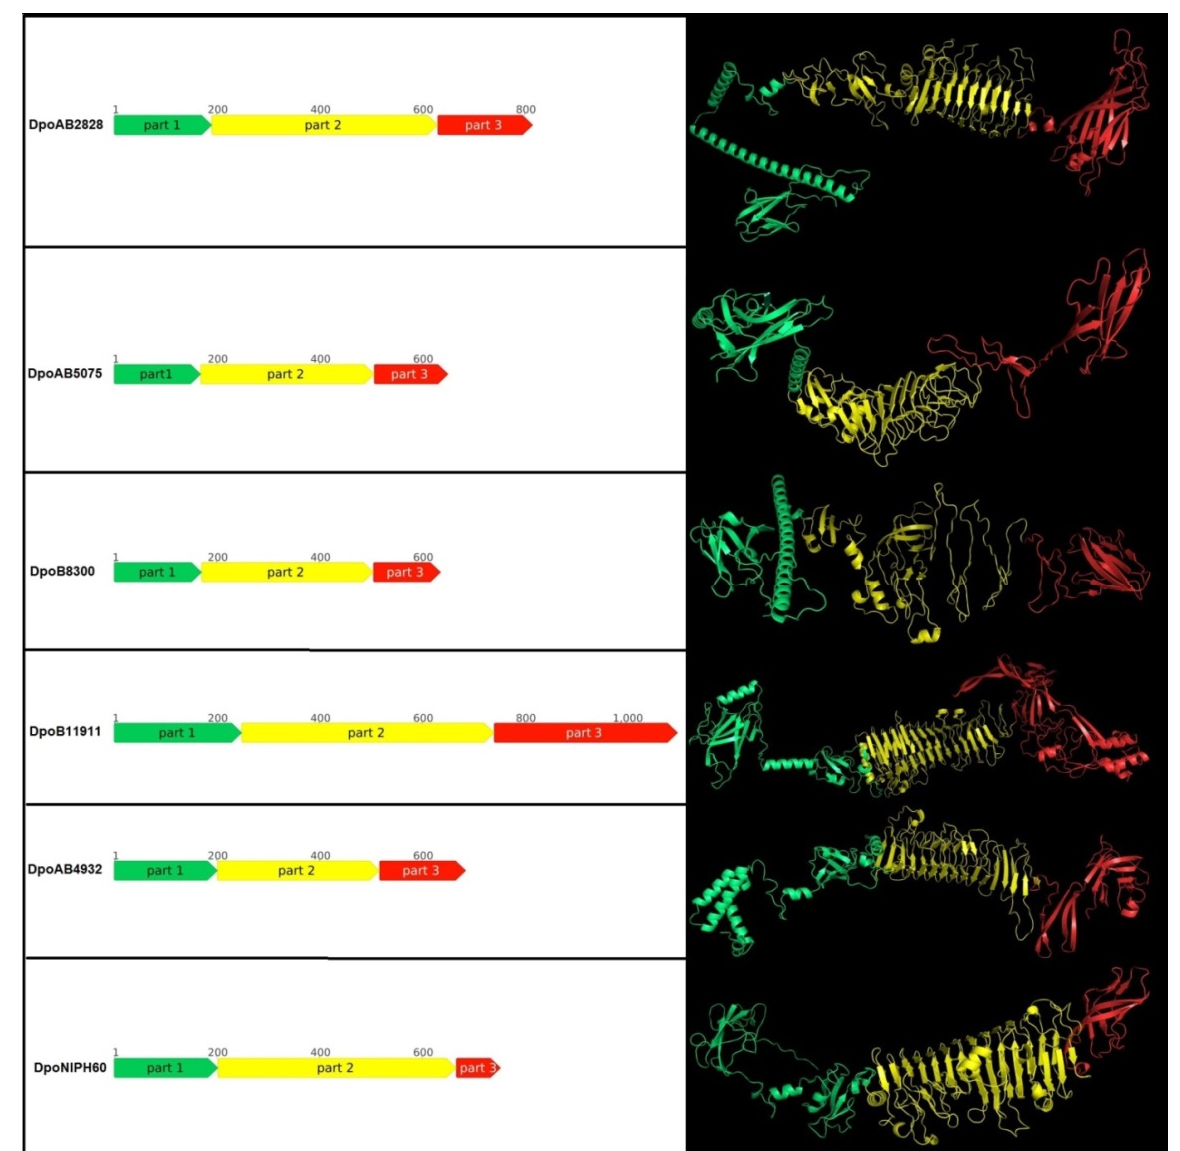
Figure 3. Schematic representation and predicted spatial structure of the prophage-derived depolymerases. The parts of proteins are coloured according to their suggested roles. Part 1 (coloured green) contains the particle-binding N-terminal domain, part 2 (coloured yellow) contains the central pyramidal domain, the part 3 (coloured red) contains C-terminal domain.